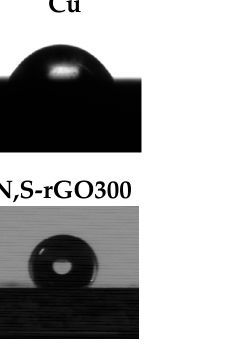
Figure 5. The contact angle images.